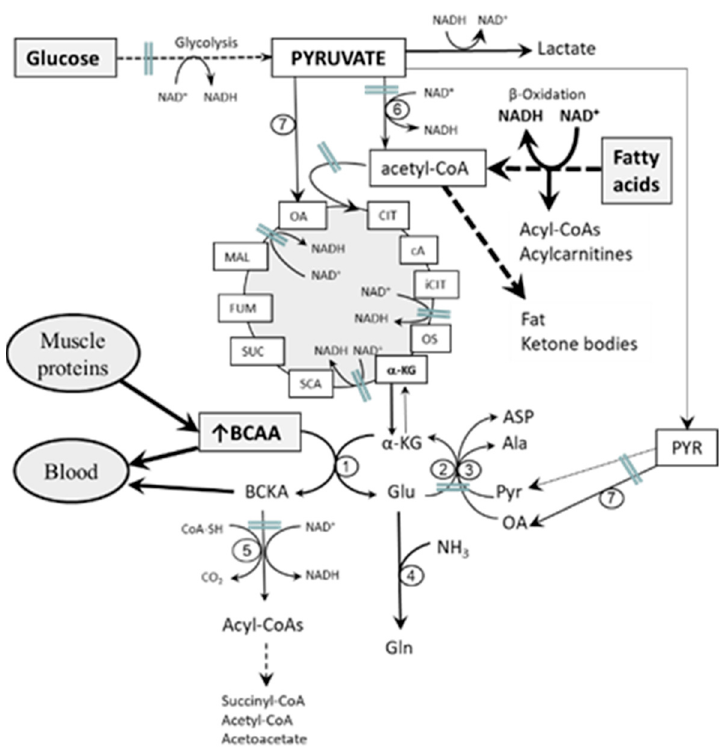
Figure 3. Role of skeletal muscles in the etiopathogenesis of increased BCAA levels in starvation and diabetes. Starvation and diabetes are characterized by decreased glycolysis and the preferential use of fatty acids as an energy source. The consequences are (i) decreased flux through the citric cycle, (ii) decreased supply of amino group acceptors ( α -KG, OA, and PYR) for BCAAT and ALT and AST reactions, (iii) excessive production of NADH and acyl-CoAs with different lengths of carbon chain due to activated, but incomplete, oxidation of fatty acids, and, subsequently, (iv) decreased flux through BCKAD. 1, BCAAT; 2, ALT; 3, AST; 4, glutamine synthetase; 5, BCKAD; 6, pyruvate dehydrogenase; 7, pyruvate